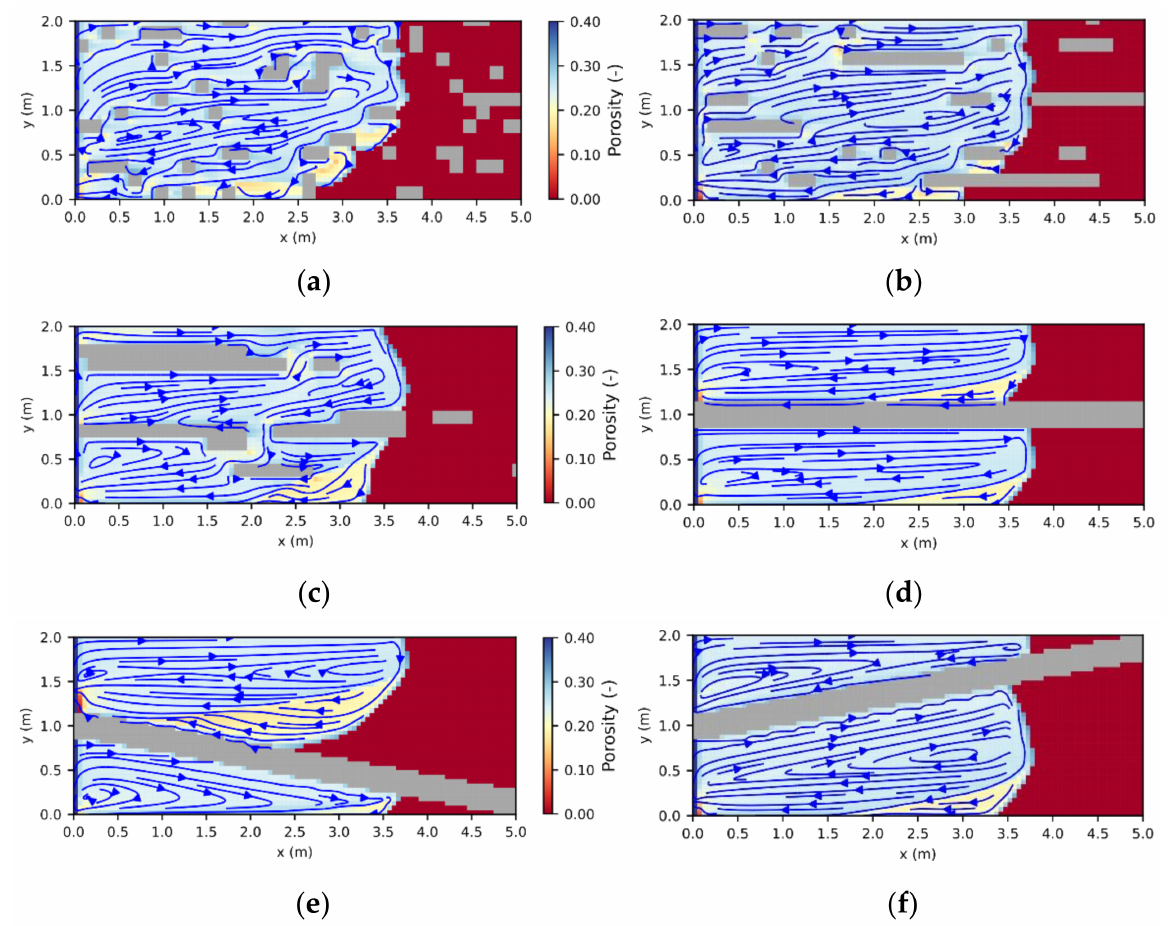
Figure 10. Porosity distribution after a simulation time of 10 years for heterogeneous potash seams with halitic inclusions for the distributions ( a ) 2:1, ( b ) 17:0.5, ( c ) 34:1 and intersecting layers with ( d ) 0 ◦ , ( e ) +10 ◦ , ( f ) − 10 ◦ inclination and k max = 5 × 10 − 6